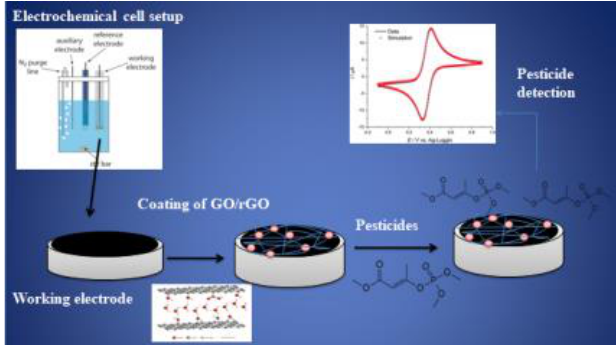
Figure 5. GO/rGO for the electrochemical sensing of pesticides.